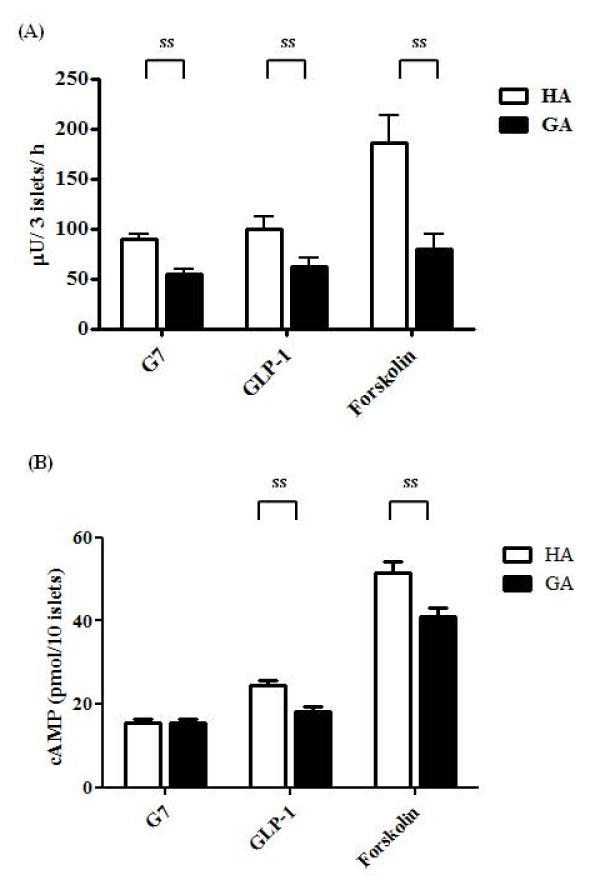
Effects of GLP-1 and forskolin on insulin secretion. (A) Rat islets were incubated for 24 h at 37°C with 0.1 mg/mL HA (white bar) or GA (black bar), in the presence of 10 nM GLP-1 or 10 μM forskolin, under the G7 condition. Each bar represents the mean plus SEM of 3 separate experiments, each with n = 5. (B) Dissociated islet cells were cultured overnight at 37°C in DMEM with 5% FCS. Islet cells were preincubated for 30 min at 37°C in KRBH (0.4 mL) in the presence of GLP-1 or forskolin, under the G7 condition. ss; statistically significant.